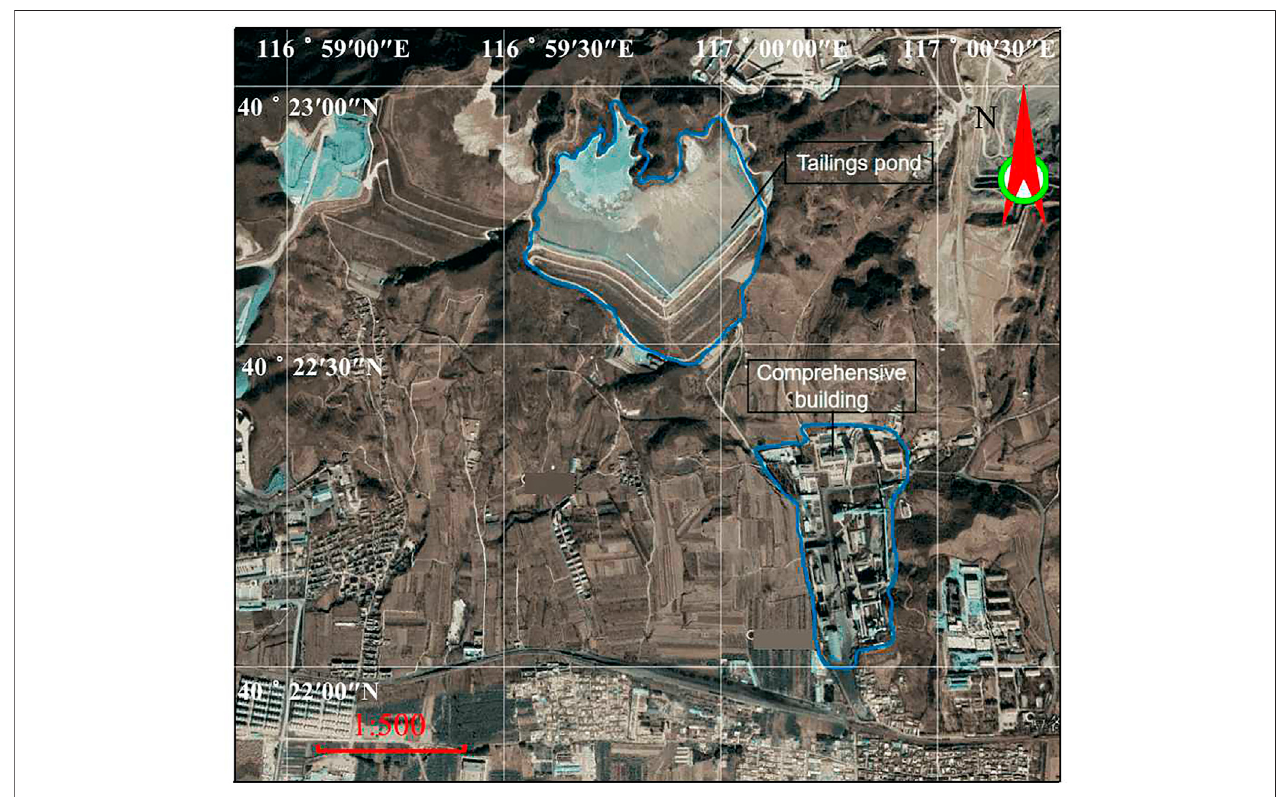
FIGURE 5 | Satellite image of tailings pond simulation